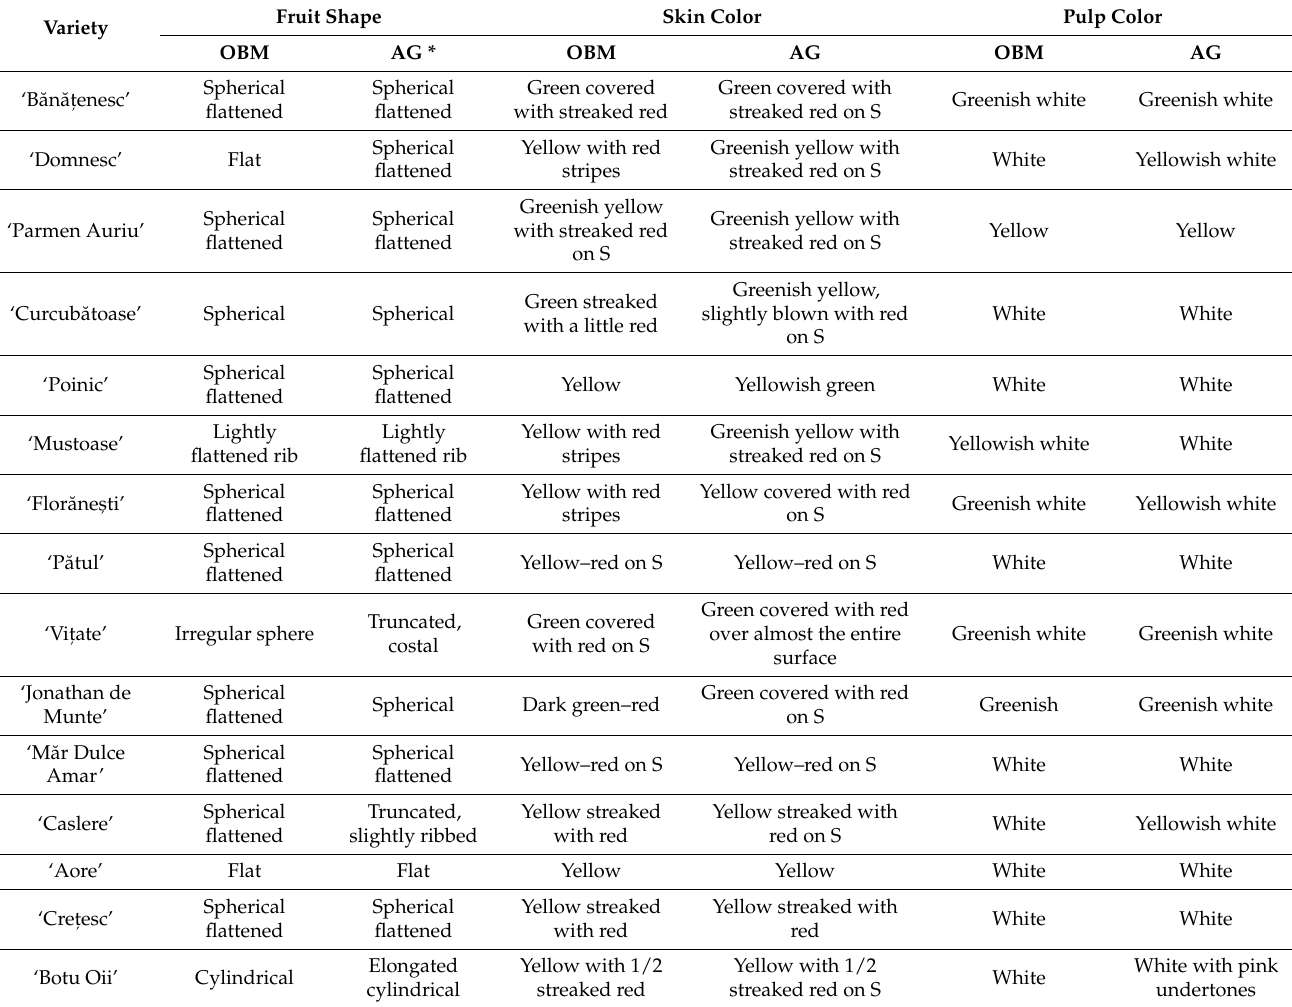
Table 7. Fruit shape, skin and pulp color before and after